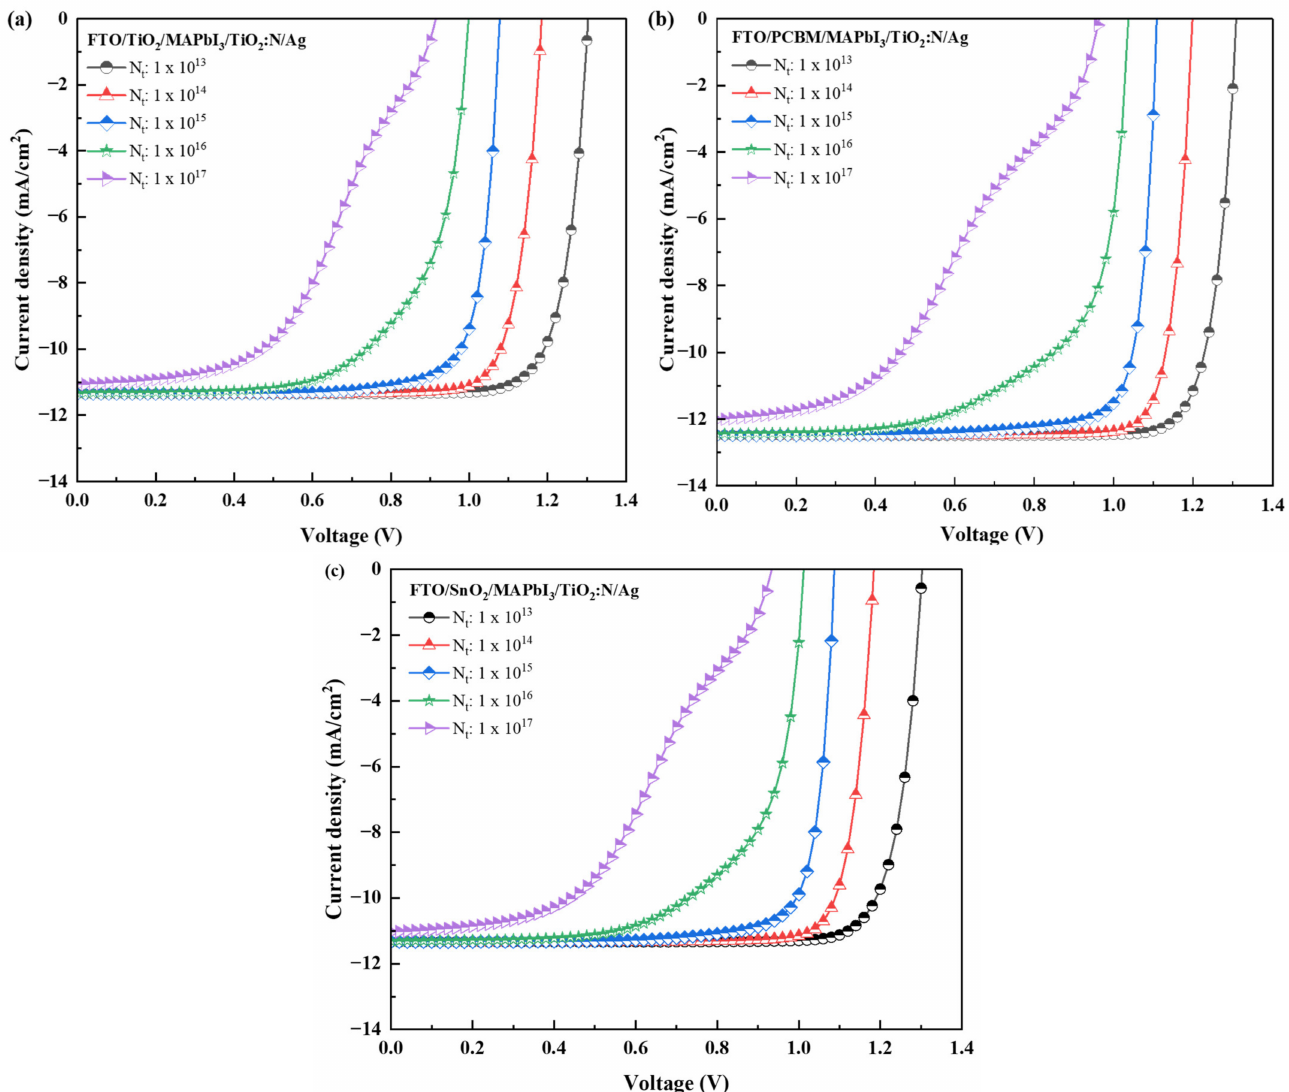
Figure 6. J-V characteristics of the PSC structures with TiO 2 :N as HTL and TiO 2 as ETL ( a ); PCBM as ETL ( b ); and SnO 2 as ETL ( c )